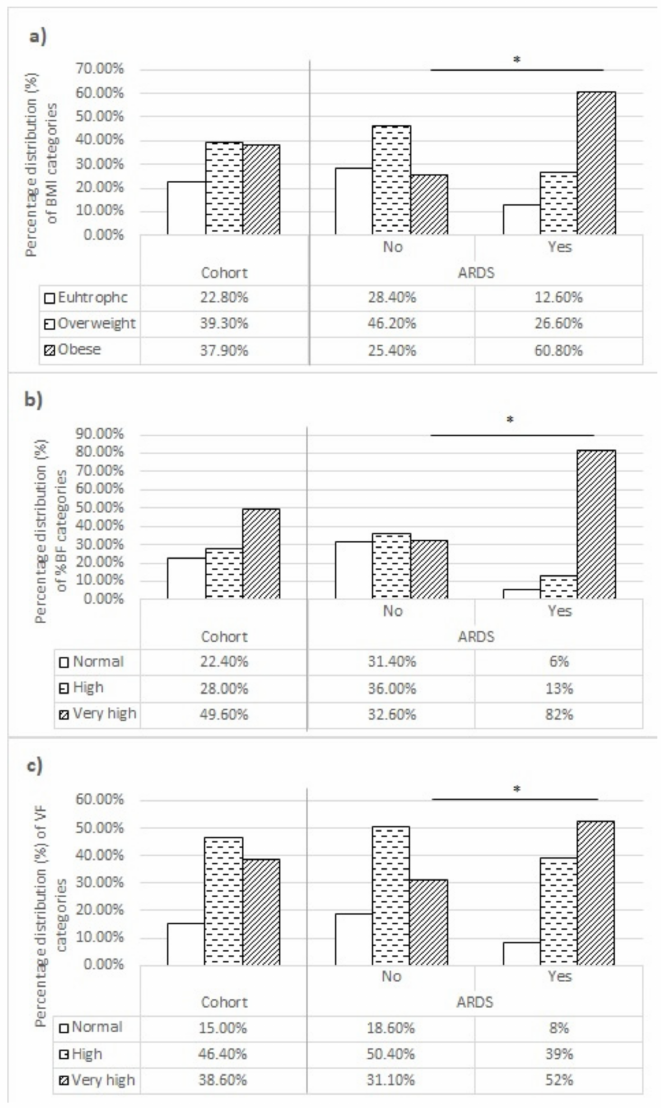
Figure 1. Percentage distribution of body composition categories for ( a ) BMI, ( b ) %BF, and ( c ) VF level, with regard to ARDS development. Abbreviations: ARDS—acute respiratory distress syndrome;